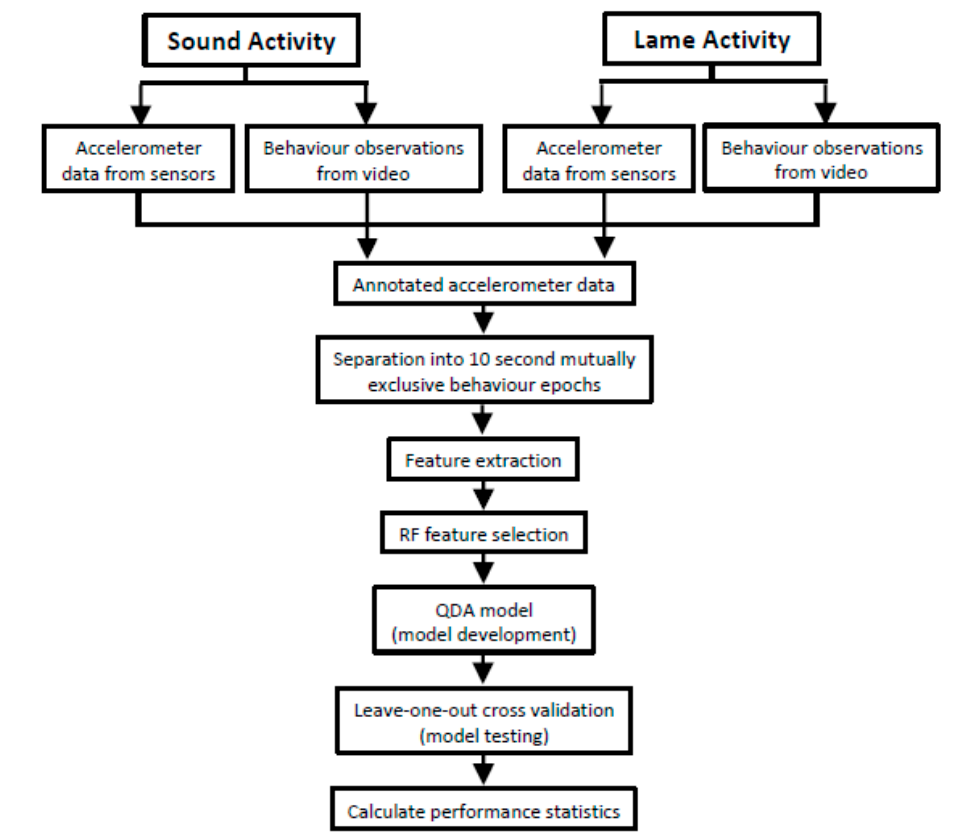
Figure 2. Workflow of the steps employed to classify sheep behaviour from a tri-axial accelerometer.